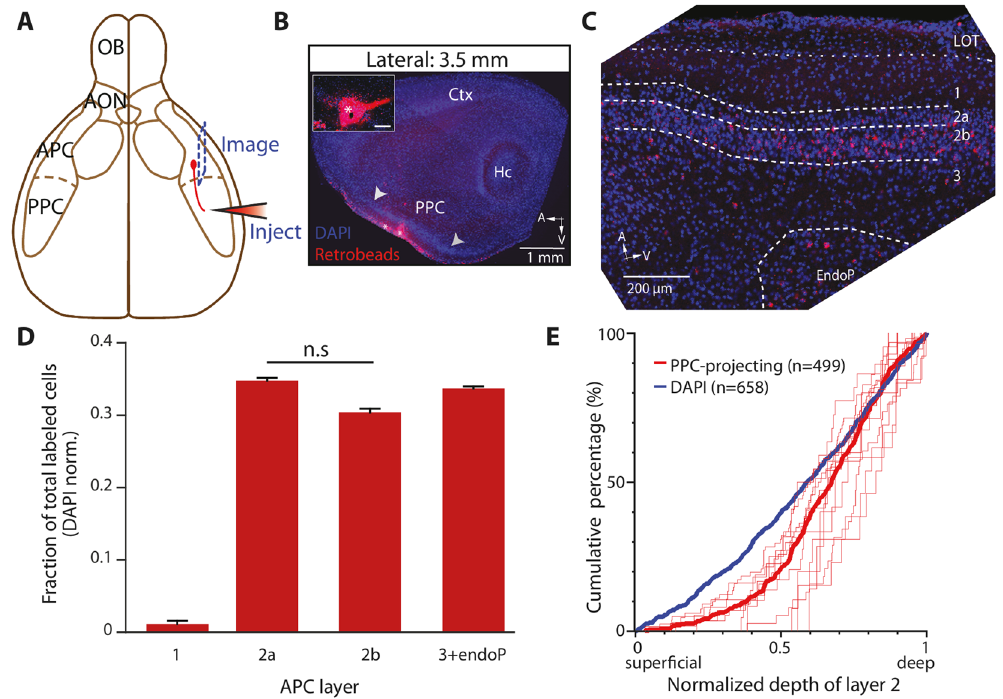
Figure 2. Projections from the APC to the PPC arise more homogeneously from both layer 2a and 2b. ( A ) Schematic representation of the injection of tracer into the PPC, and imaging from sagittal sections of APC. ( B ) Injections of tracer were targeted to the PPC. * , injection site. Arrowheads, PPC limits. Hc, hippocampus; Ctx, neocortex. Inset , zoom-in view of the injection site. Note the presence of LOT in the APC but not PPC. ( C ) Retrogradely labeled cells were found in APC sagittal sections. For B and C, red: tracer. Blue: DAPI. ( D ) Bar graph showing the relative fractions of retrogradely labeled neurons, normalized by the number of DAPI cells in each layer. PPC-projecting neurons were heterogeneously distributed across APC layers (p = 0.012, n = 581 Retrobeads + cells and 2529 DAPI + cells, 5 sections, 4 mice, Friedman test), with labeled cells mainly located in layer 2a, 2b and in layer 3 + EndoP. No statistical difference was found between layer 2a and 2b when fractions were corrected for variations in cell densities across layers (p = 0.46, n = 155 layer 2a cells and 191 layer 2b cells, Dunn’s multiple comparisons post-hoc test). n.s, not significant. ( E ) Within layer 2, projecting neuron distribution was skewed toward deeper part of layer 2 (p < 0.0001, n = 499 Retrobeads + neurons, n = 658 DAPI + cells, 12 sections, 5 mice, Kolmogorov-Smirnov test). Thin red traces represent the counting for single sections, while the thick red trace shows the distribution of all the counted cells. The thick blue trace is the distribution of the DAPI +